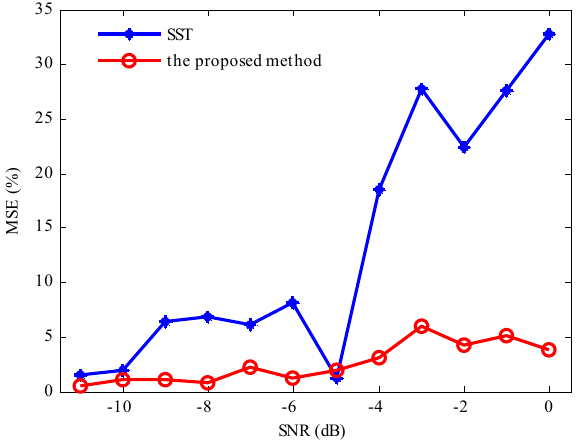
Figure 7. The comparison of error rate between SST and the proposed method.